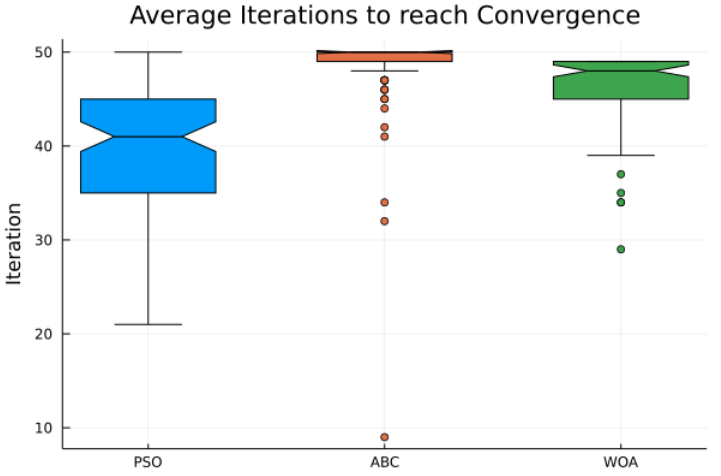
Figure 14. The best PSO converged in the 21st iteration, while WOA and ABC were close to the 30th. Considering the number of iterations until convergence, PSO used 42 iterations, while ABC used 50, and WOA used 47.